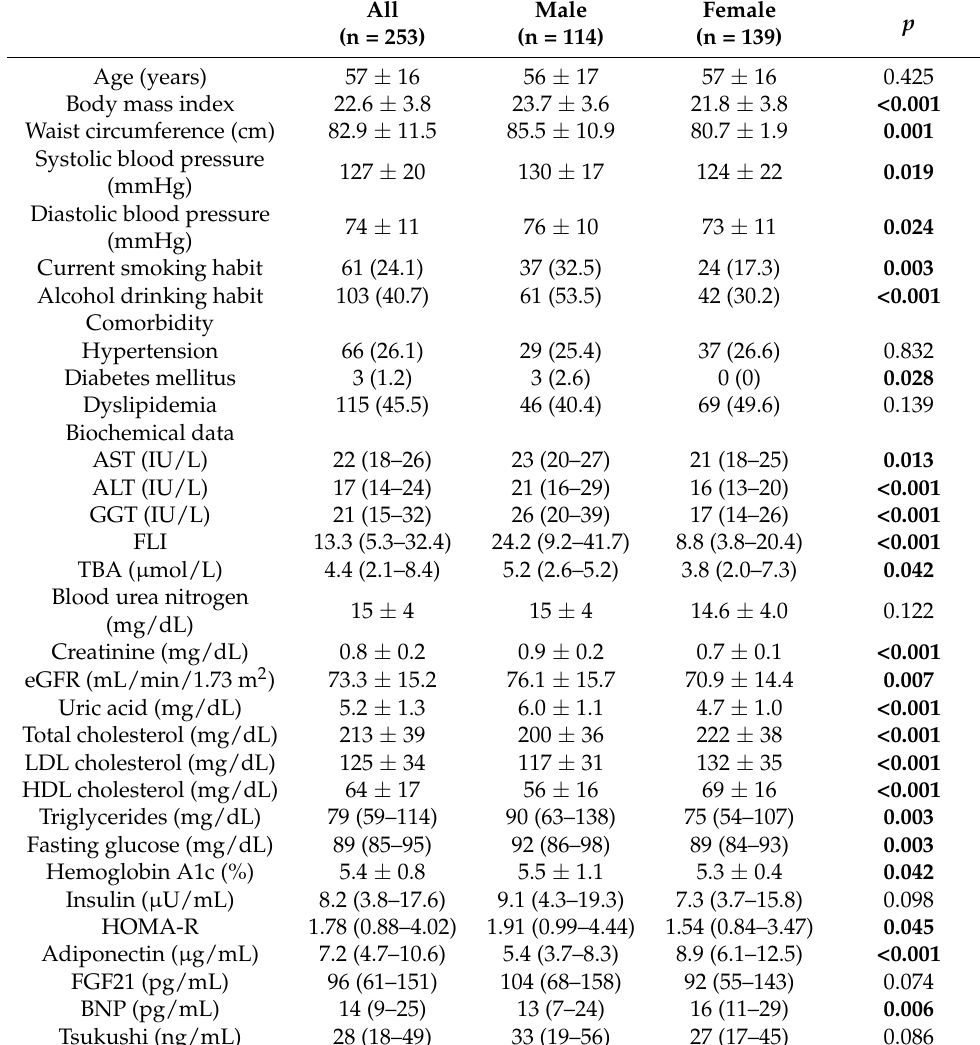
Table 1. Characteristics of the studied